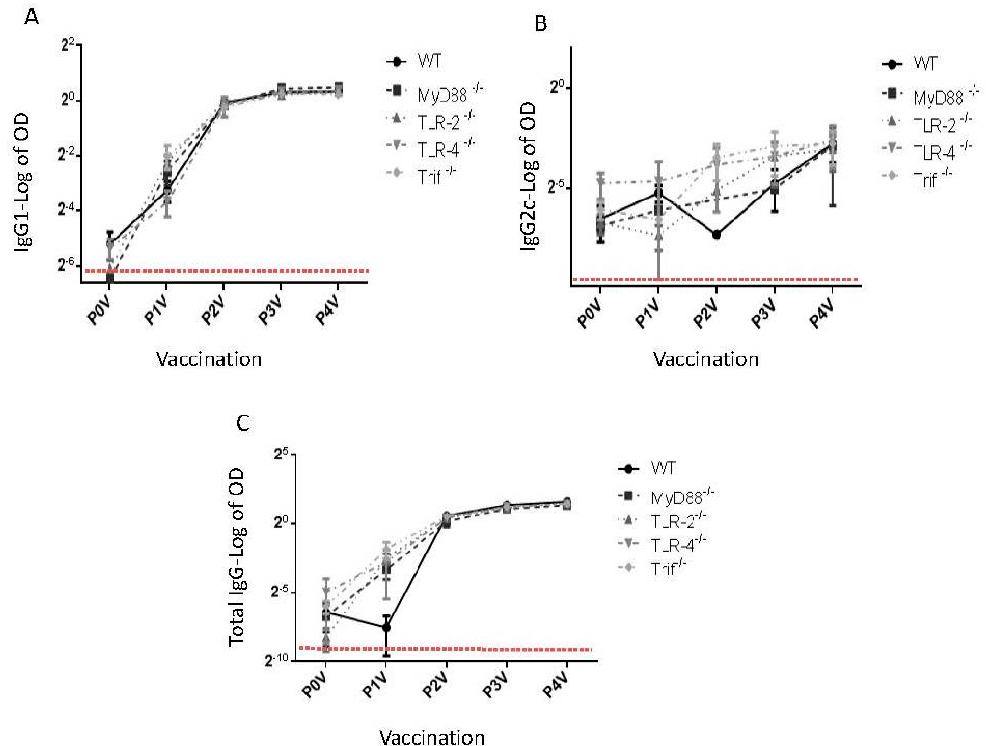
Figure 1. TLR signaling is dispensable for V. cholerae -specific antibody production following oral immunization with Dukoral vaccine. TLR mutant mice and WT controls ( n = 5 mice per group) were orally immunized on days 0, 10, 20, and 30, with 3 × 10 9 V. cholerae and 10 μ g CTB. Serum was collected 9 days after each vaccination and V. cholerae -specific antibody titer against A , IgG1, B , IgG2a, and C , IgG-Fc was measured by ELISA. The plates were coated with 50 μ L of 12 × 10 6 V. cholerae /mL. The next day, coating buffer was decanted and plates were washed once in PBS. Plates were then blocked for 2 h at 37 °C with 2% FCS-PBS. After blocking, plates were washed once in PBS and diluted samples were added to duplicate wells. After incubating for 1 h at 37 °C, plates were washed with PBS and then incubated for 1 h at 37 ° C with 50 μ L of secondary horseradish peroxidase (HRP)-conjugated secondary antibody in 2% FCS-PBS (goat anti-mouse A. IgG1, B. IgG2a, C. IgG-Fc). Plates were then washed and developed with 3,3 ′ ,5,5 ′ -tetramethylbenzidine (TMB) one component HRP microwell substrate. The reaction was stopped by stop solution and plates were read on at 450 nm. The naïve control data are shown as dashed line. Results are shown as the mean log of O.D 450 nm ± SEM. P0V denotes pre-vaccination serum. P1V − P4V denotes post-1st vaccination through post-4th vaccination time points. The production of IgG, IgG1, and IgG2c was not statistically significant ( p ≥ 0.05).